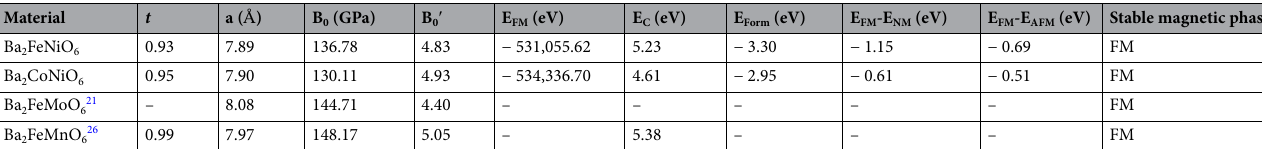
Table 1. Ground-state parameters of Ba 2 BNiO 6 double perovskites namely tolerance factor ( t ); lattice constant (a); bulk modulus (B 0 ) and its pressure derivative (B 0 ′ ); optimized energy of FM phase (E FM ); enthalpy of formation per atom (E Form ), cohesive energy per atom (E C ); energy difference between different magnetic phases E FM -E NM and E FM -E AFM .